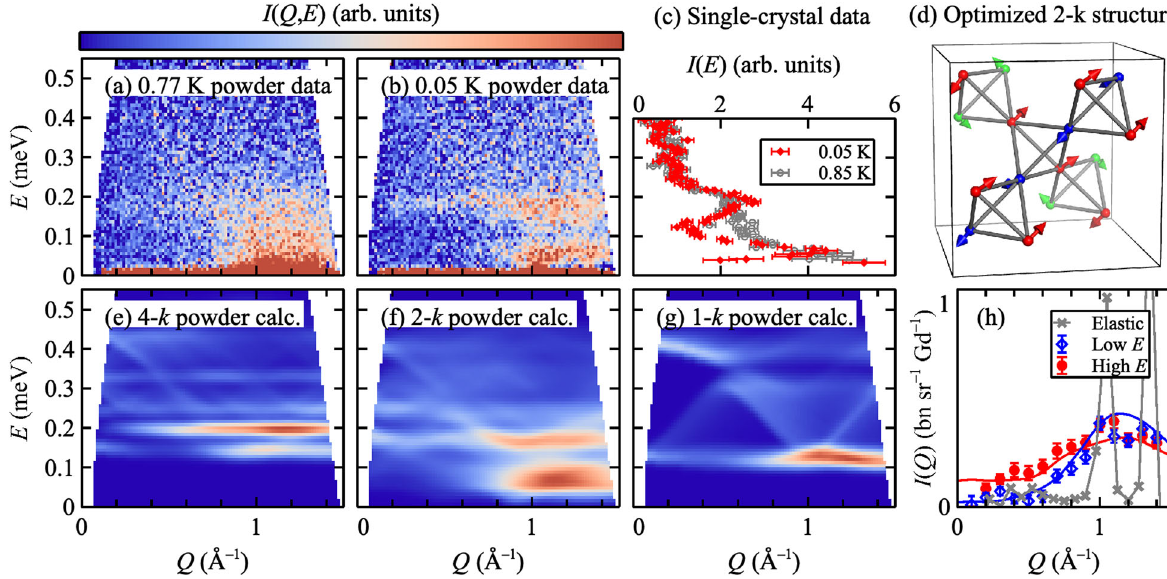
Fig. 4 Inelastic neutron-scattering data and spin-wave models. a Inelastic neutron scattering data collected on a powder sample in the intermediate phase (0.77 K). b Powder INS data collected in the low-temperature phase (~0.05 K). c Single-crystal INS data integrated over ð h ; k ; l Þ ¼ ð 0±1 ; 0±1 ; 3 Þ in the low-temperature phase (0.05 K, solid red diamonds) and intermediate phase (0.85 K, empty gray circles). ± 1 2 2 Error bars represent one standard deviation. d Optimized 2- k magnetic structure. e Powder-averaged linear spin-wave theory (LSWT) calculation for the L 1 + 4- k structure. f Powder LSWT calculation for the optimized ( L 1 + , L 3 + ) 2- k structure discussed in the text. g Powder LSWT calculation for the L 1 + 1- k structure. h Powder INS data and spin-wave calculations at 0.05 K. Experimental data are given in absolute intensity units by normalization to the nuclear Bragg pro fi le. Gray crosses show the measured elastic line ( ∣ E ∣ < 0.03 meV) with the incoherent scattering cross-section subtracted, empty blue diamonds show the measured low- E mode (0.03 ≤ E < 0.12 meV), and fi lled red circles show the measured high- E mode (0.12 ≤ E ≤ 0.21 meV). Spin-wave calculations for low- E and high- E modes are shown as blue and red lines, respectively, and have been vertically scaled by the same factor to match the experimental